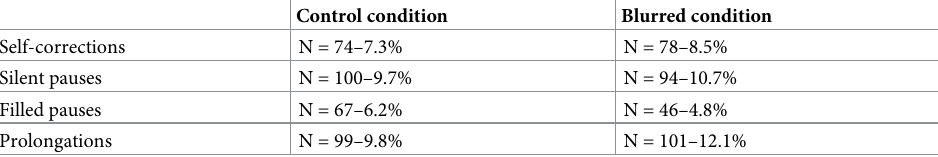
Table 3. Number of disfluency produced in control vs. blurred condition and proportion of pictures